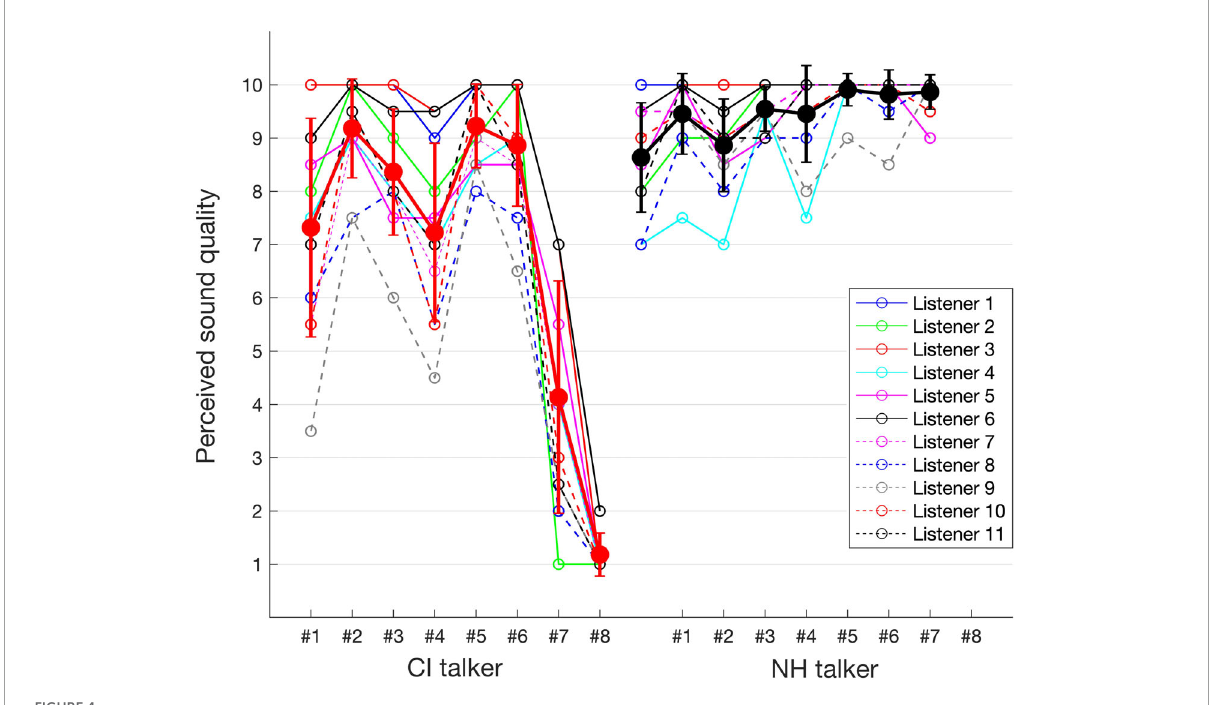
FIGURE4 Individual listener assessed sound quality data point for the speech passages spoken by CI and NH talkers and also showing the mean and SD of the sound quality ratings for the CI and NH talker groups.